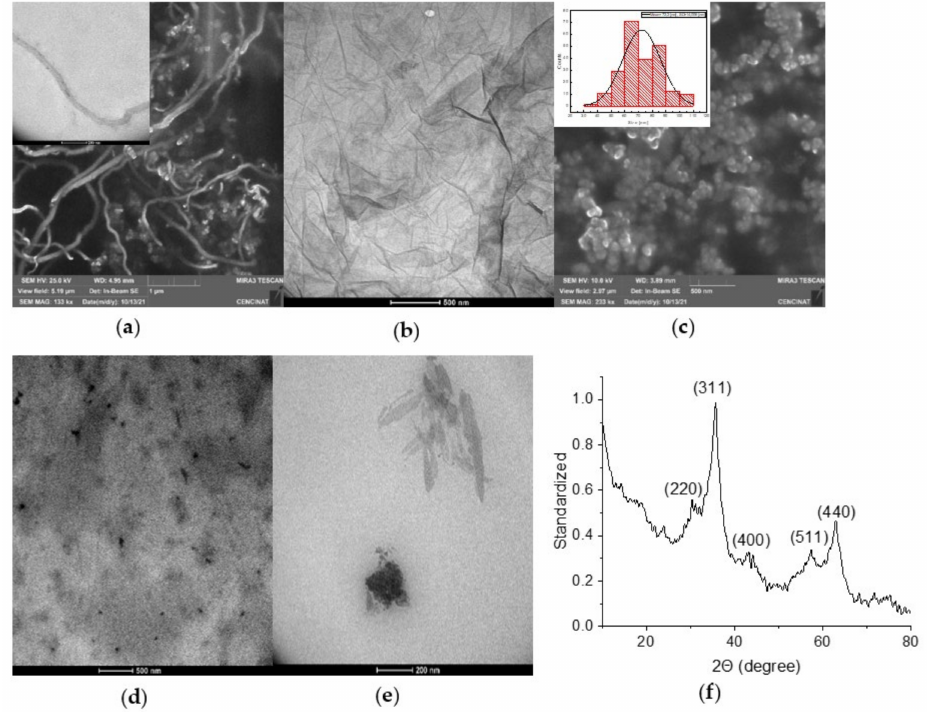
Figure 8. ( a ) SEM and TEM images of purified MWCNTs; ( b ) TEM of GO; ( c ) SEM of MNPs. ( d ) TEM of VCL/PEGDA-MNPs-MWCNTs-ZnMintPc. ( e ) TEM of VCL/PEGDA-MNPs-GO-ZnMintPc; ( f ) XRD analysis of